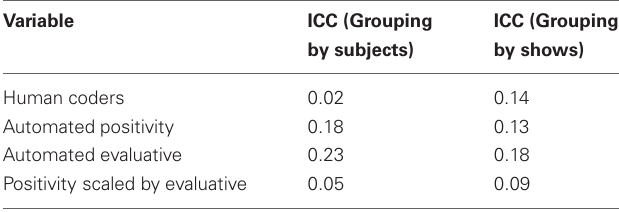
Table 2 | Intraclass correlation coefficients representing the proportion of variance in each rating of interest that occurred between subjects (or between shows), compared to the total (between + within)